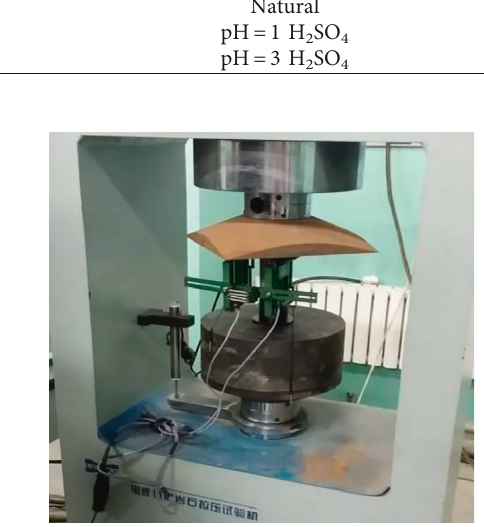
Figure 2: Uniaxial compression test.